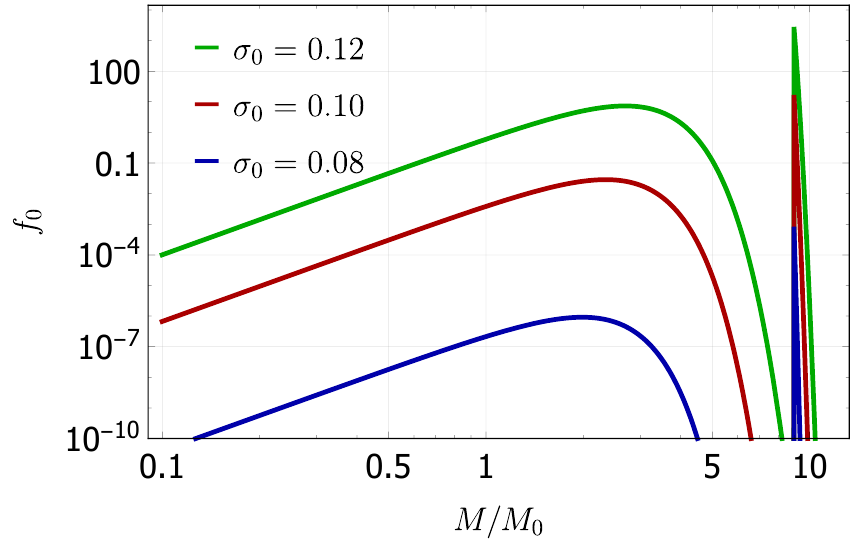
Figure 5. The PBH fractions f 0 are plotted as functions of M / M 0 for σ 0 = 0.08, 0.10 and 0.12 with k 0 = 10 5 k eq . The right spiky plots show the PBH fractions without the critical behavior, and the left broader plots show those with the critical behavior.